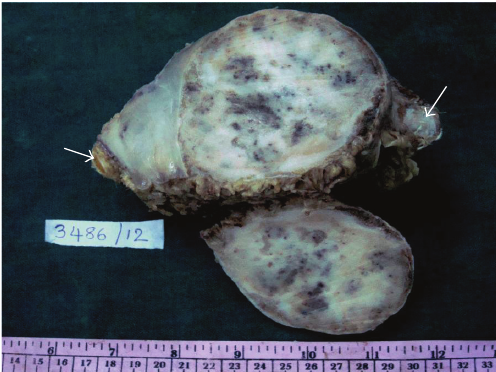
Figure 2: Gross: firm, well defined solid grey white expansile mass replacing the medullary cavity of the rib (arrow) with areas of